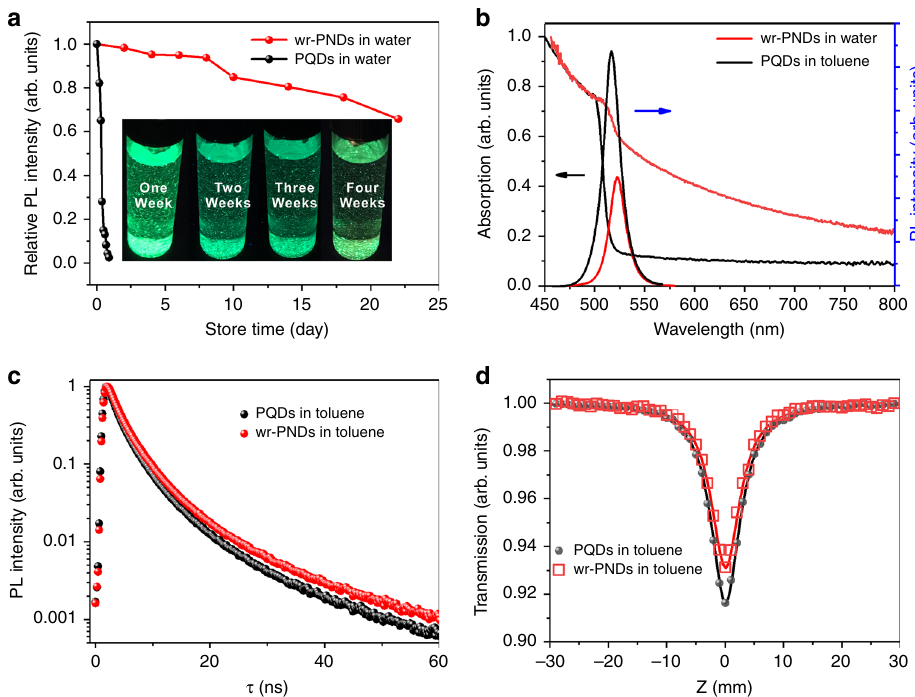
Fig. 3 Comparison of optical properties between wr-PNDs and PQDs. a Relative PL intensities of wr-PNDs and PQDs stored in water for different periods of time. b UV-visible absorption and PL spectra of PQDs in toluene and wr-PNDs in water. c Time-resolved PL spectra of PQDs and wr-PNDs in toluene. d Open-aperture z-scan curves measured on the toluene solution of PQDs and wr-PNDs. Source data are provided as a Source Data fi